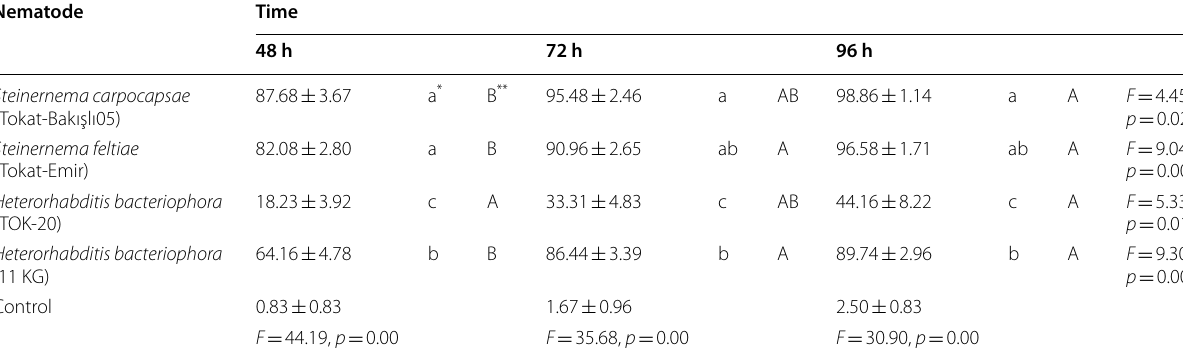
Table 6 The mortality rate of fifth stage cotton leafworm larvae at different exposure times